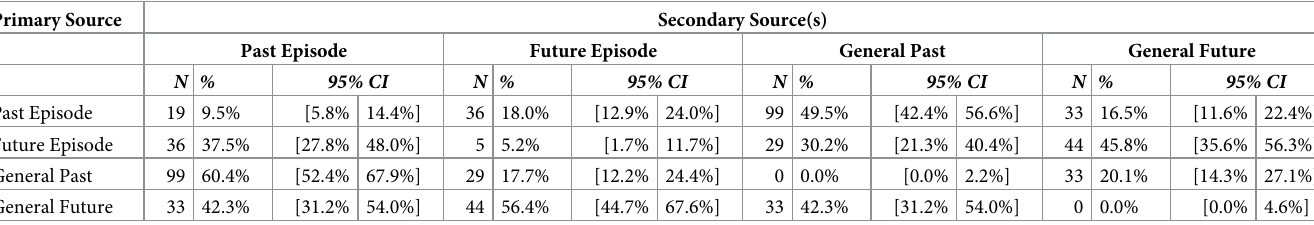
Table 3. Co-occurrence of waking sources by